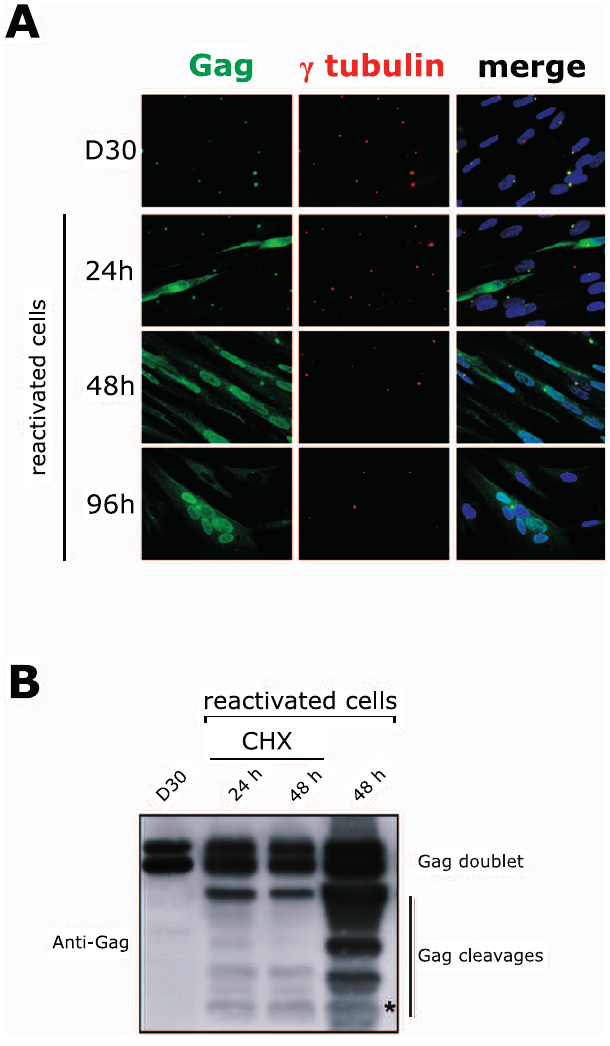
Figure 3. Reactivation of PFV-Infected Resting Cells (A) Sub-cellular localization of Gag proteins (green) studied by confocal microscopy following indirect immunofluorescence using anti-Gag antiserum. Thirty days p.i., Gag proteins mainly localize at the MTOC (stained with anti- c -tubulin abs in red) in resting cells. In contrast, Gag proteins are detected both in the cytoplasm and the nucleus of these cells at 24, 48, and 96 h post-activation by splitting and serum addition. Syncitia, characteristic of a productive FV infection, appear 96 h post- reactivation. (B) Western blot analysis of protein extracts from resting and activated PFV-infected cells with or without CHX treatment (150 l g/ml). At 30 d p.i. (with m.o.i. of 2), only the Gag doublet at 68 and 71 kDa is detected in resting cells using anti-Gag abs. Under CHX treatment, at 24 h post- reactivation, Gag cleavages are clearly detected, including the 38-kDa Gag product (*) involved in virus uncoating